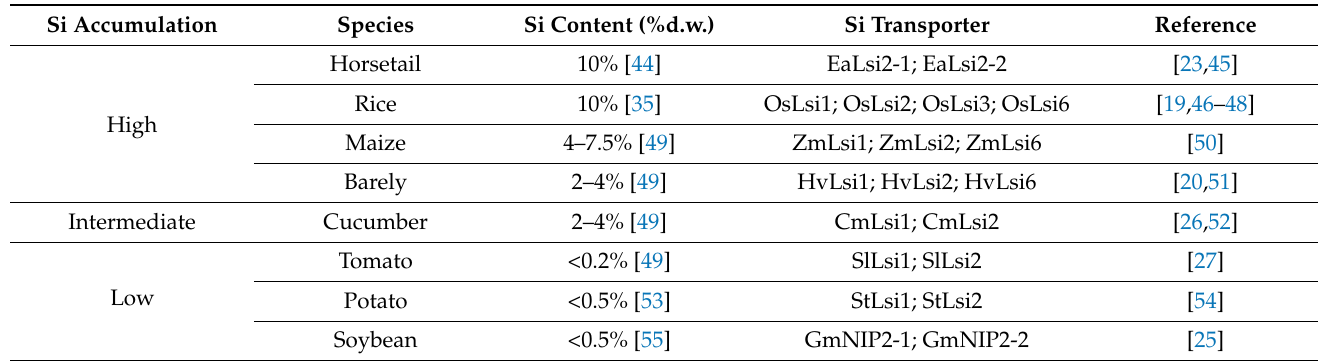
Table 1. Si content and Si transporters in various plants with different Si uptake